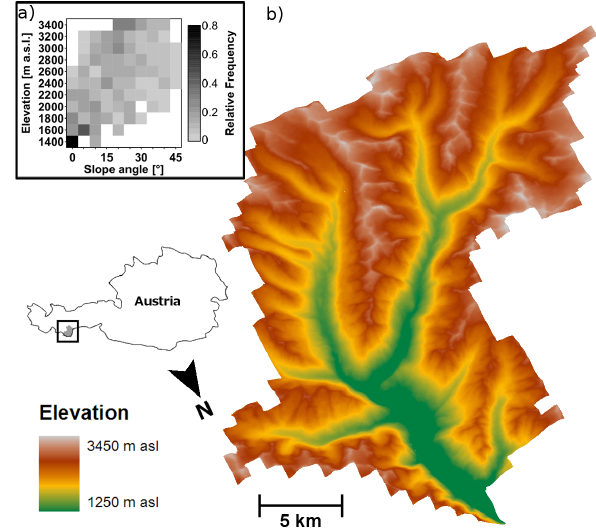
Figure 6. Elevation levels of the Ötztal using a 1 × 1km grid (b) . Frequency distribution of slope angles derived from 1 × 1km grid is shown (a) . Slopes in general are steeper in the summit regions than in the valleys. Note that instead of the average slope of a grid cell only steepest vertical gradients are